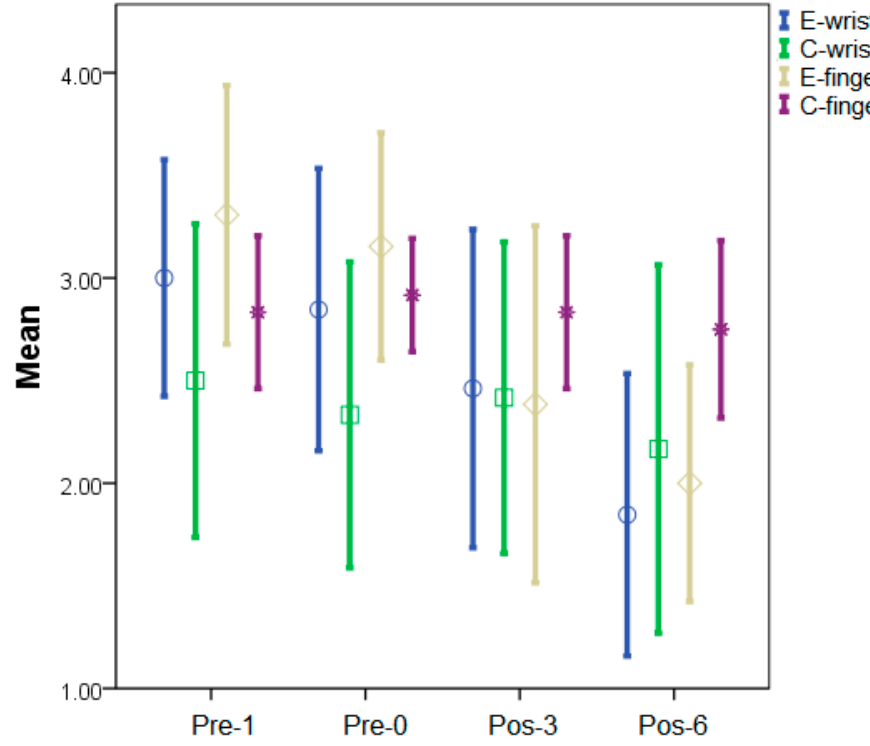
Figure 3. Sequential changes in mean MAS scores for the wrist and finger flexors in the study. Mean values and ± 1 standard error were displayed. E-wrist: wrist flexors in the experimental group; C-wrist: wrist flexors in the control group; E-finger: finger flexors in the experimental group; C-finger: finger flexors in the control